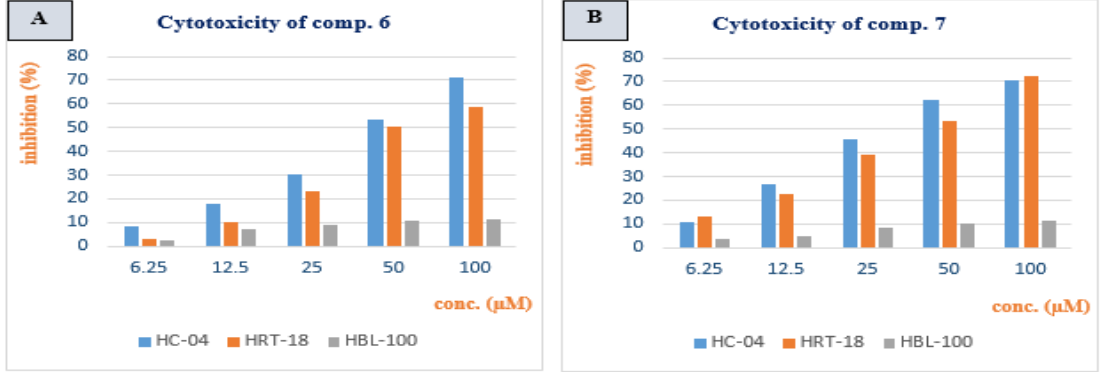
Figure 4. Histogram showing the concentration and growth inhibition of the tested compounds against hepatic carcinoma cells (blue), colon adenocarcinoma (orange) and healthy breast cells (gray). (A): the cytotoxicity of compound 6. (B): the cytotoxicity of compound 7 Compound 7 shows higher cytotoxicity than those for compound 6 are 45.83 µM and 47.93 µM. compound 6 against the tested cancer cells ( Figure Figure 6 (captured at the IC 50 ) shows the difference 5). Its IC 50 against HC-04 cell line and HRT-18 cell in the magnitude of cytotoxicity between the two line are 29.43 µM and 33.92 µM respectively while compounds.